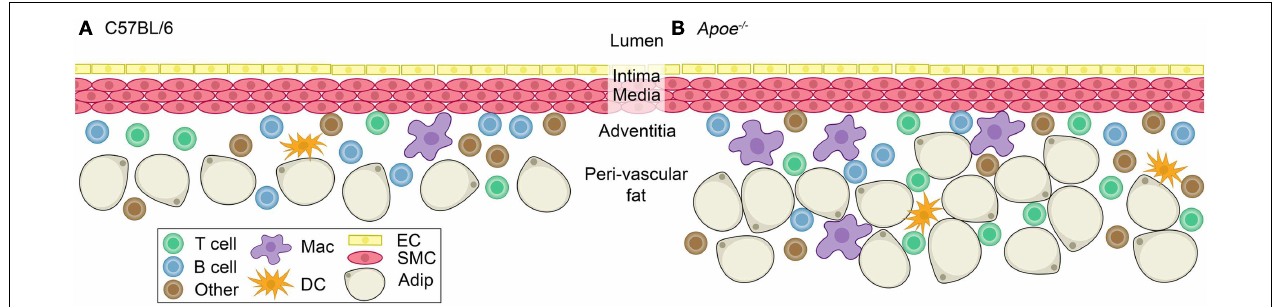
Apoe − / − mice have an increase in the number ofT cells and macrophages, with a lesser increase in dendritic cells and other cells (neutrophils, natural killer cells, and natural killerT cells) compared to C57BL/6 (Galkina et al., 2006). Abundant adventitial B cells persist in the Apoe − / − mouse (Galkina et al., 2006; Doran et al., 2012).They also have an expanded peri-vascular fat pad compared to (A) . Abbreviation: Mac, macrophage; DC, dendritic cell; EC, endothelial cell; SMC, smooth muscle cell; Adip,